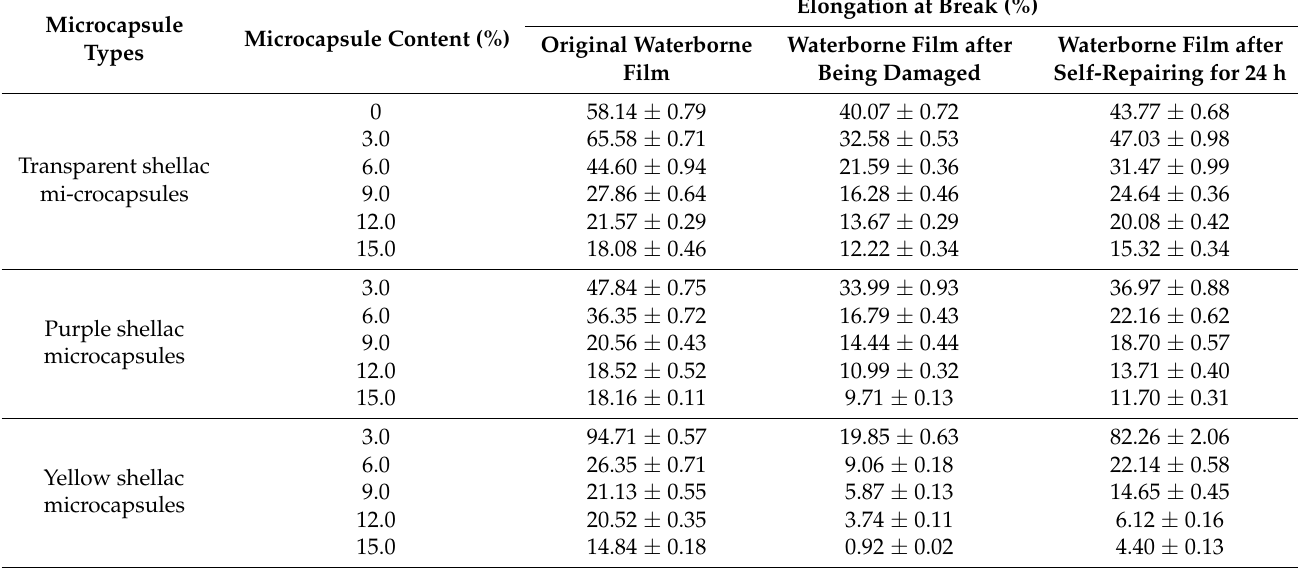
Table 5. Elongation at break results in waterborne coatings with three kinds of shellac microcapsules in three